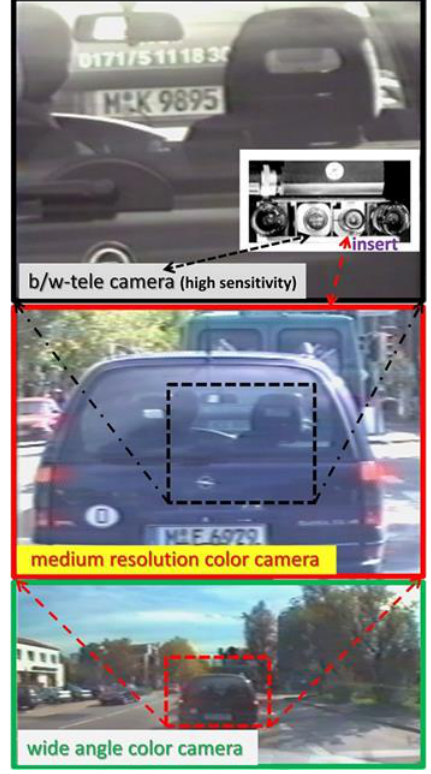
Figure 16. Tri-focal images of a traffic scene; VaMP 1999 (cameras as insert).